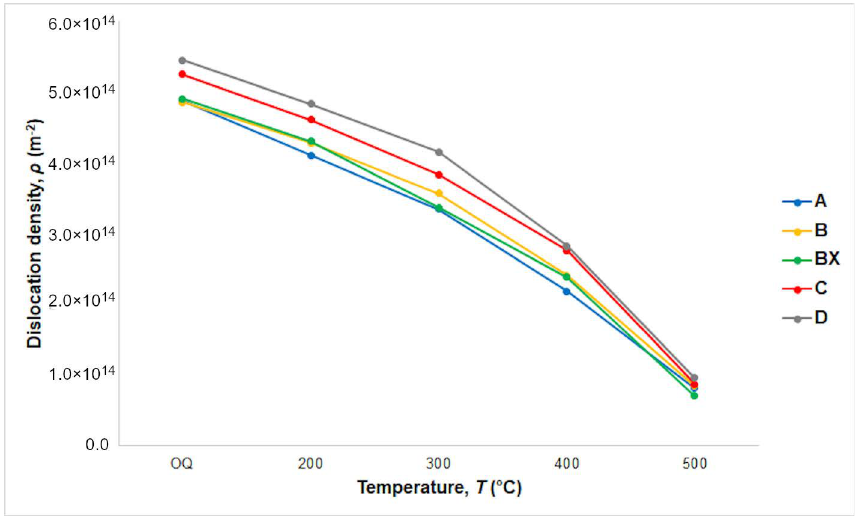
Figure 2. The dislocation density of quenched and tempered steels A, B, BX, C, and D.